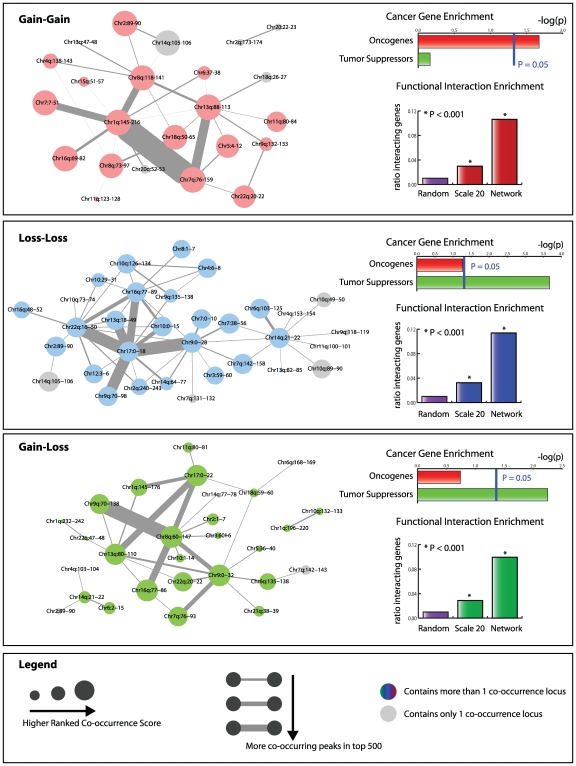
Networks of co-occurring gain and loss.The networks that result from hierarchical clustering of Scale 2 results are shown in different panels. Each panel represents either the gain-gain, loss-loss or gain-loss analysis. The resultant network is visualized using the Cytoscape software package (www.cytoscape.org). Edge thickness scales according to the number of co-occurrence links found between the two genomic loci. The size of the nodes is proportional to the highest rank found among the different individual loci that constitute a node. If only one genomic location is present in a node, i.e. this location did not cluster with any other locations, it is colored gray. The cancer gene enrichment among all genes mapping to the locations described by the nodes is shown in the top right hand corner. P-values are determined by Fisher's Exact test. The functional interaction enrichment of all genes between nodes that are linked with an edge is represented in the lower right hand corner of each panel. P-values are determined using Fishers' Exact test, with randomly generated pairs of loci representing the null hypothesis.